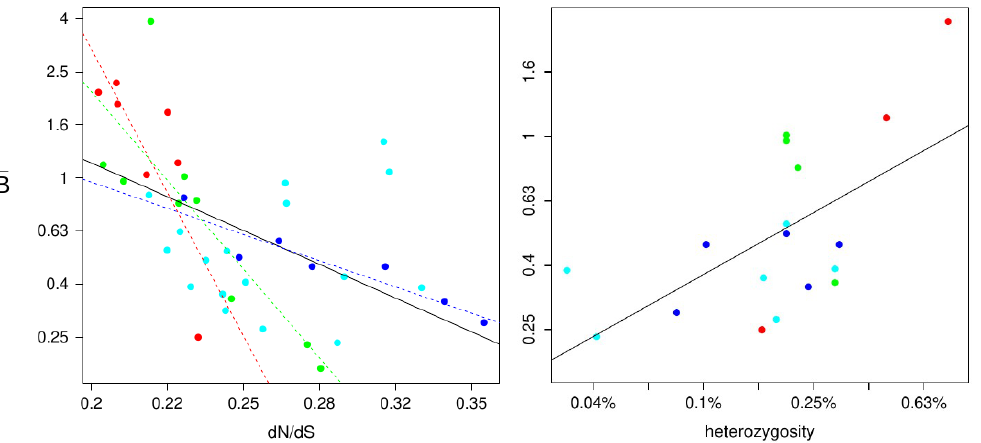
Figure 4 – Relationship between the average estimated B and dN / dS (left panel, n = 40 branches) or heterozygosity (right panel, n = 18 species) across 40 mammalian lineages in log-transformed scales. B was estimated under the M3sh model. Blue: Hominidae; cyan: Cercopithecidae; green: Bovidae; red: Muridae; black line: regression line for the whole data set; colored dotted lines: family-specific regression lines